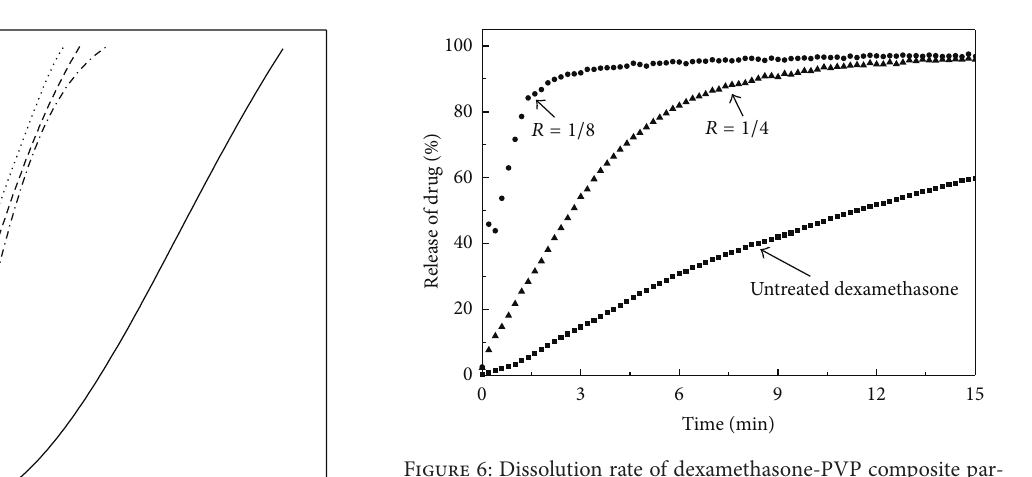
Figure 6: Dissolution rate of dexamethasone-PVP composite par- ticles produced by SAA with respect to the untreated drug, in physiological solution.